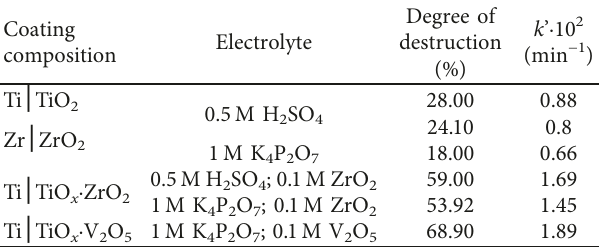
Table 5: Characteristics of the photocatalytic activity of oxide systems obtained at i 1.5A/dm 2 (cid:29)